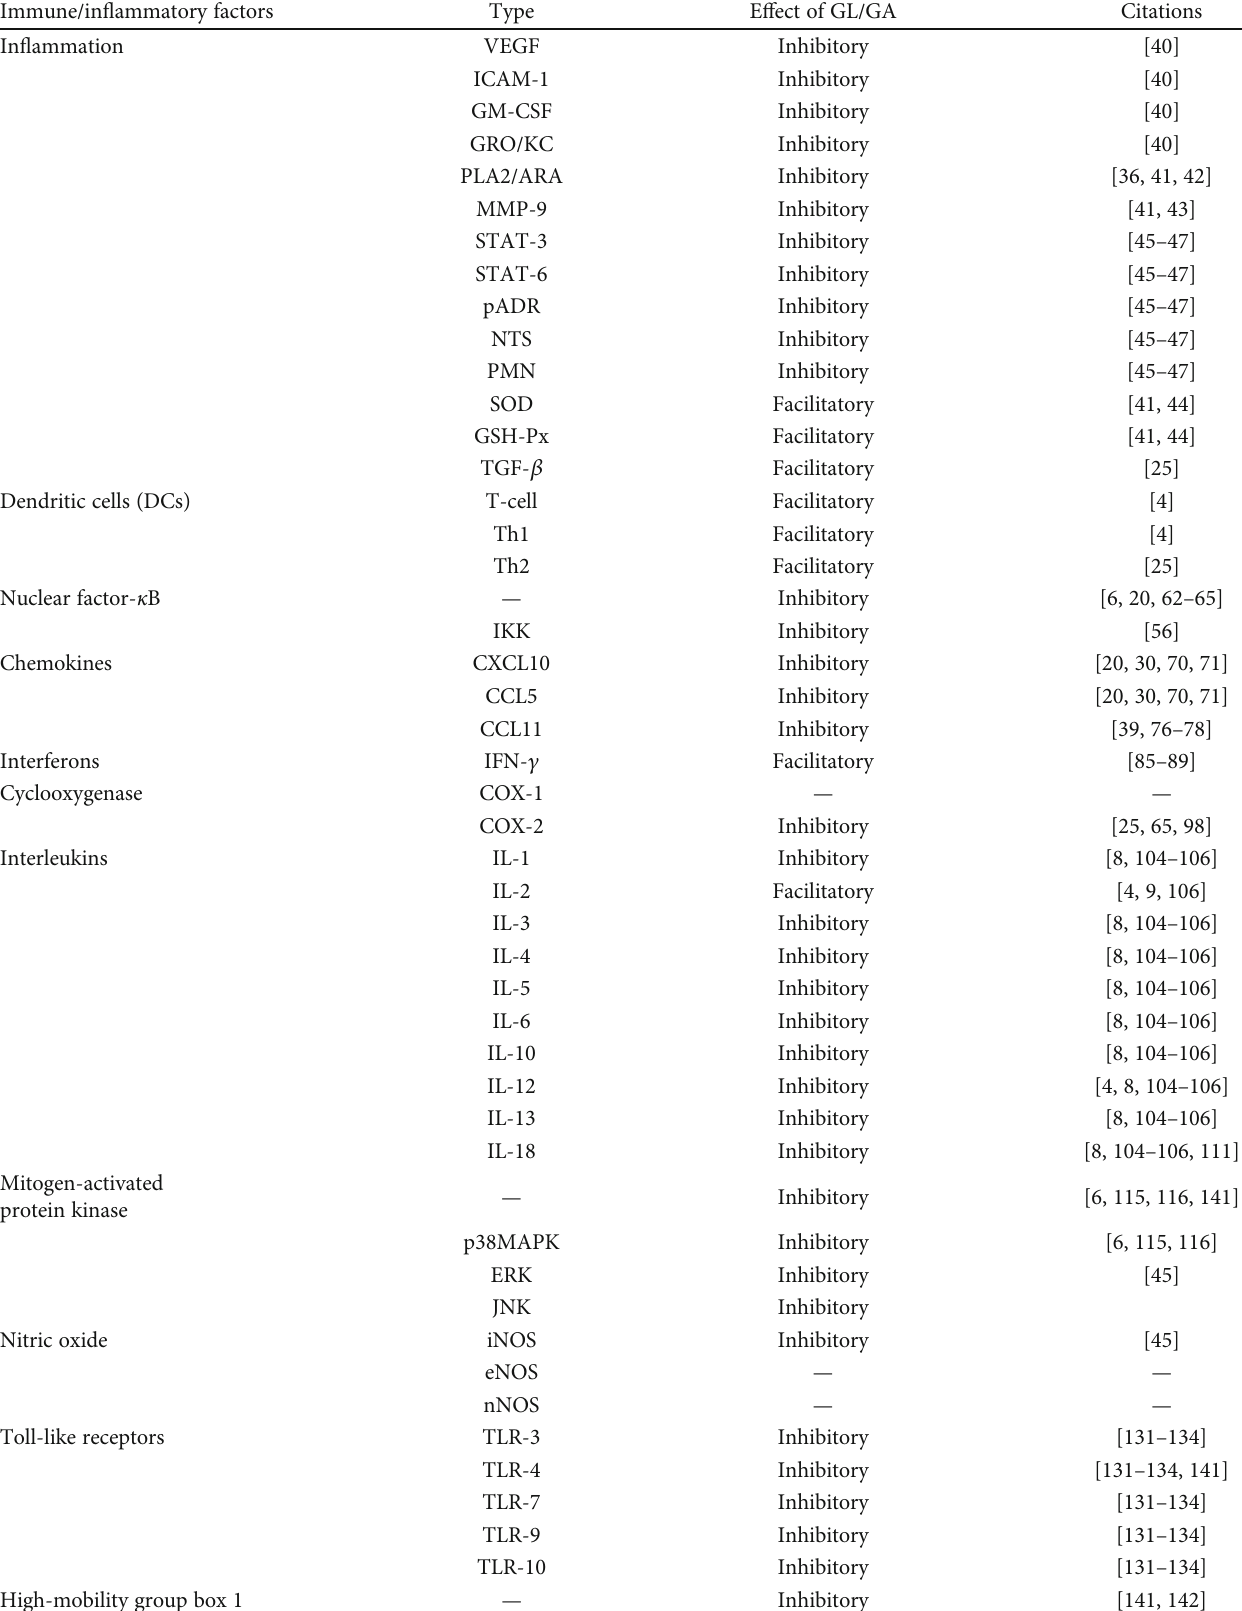
Table 1: Shows the explicit e ff ect of GL or GA on various immune/in fl ammatory